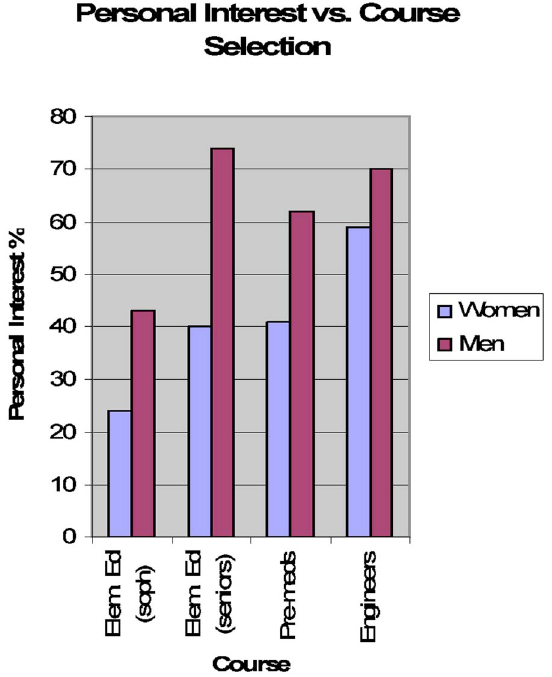
FIG. 4. (cid:1) Color (cid:2) Personal interest score for men and women in four different